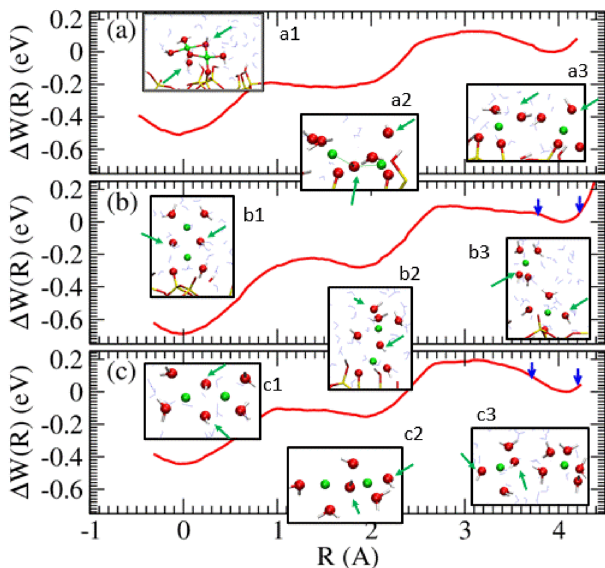
Fig. 3 AIMD/PMF pro fi les along the reaction coordinate R for the systems of Fig. 1a – c. AIMD snapshots along the pro fi le are depicted as insets. Green arrows indicate the OH − positions in the snapshots; note that OH − identity can vary in picosecond time scales. The blue arrows represent integration limits. For further detail see Sec. S4. Δ G dimer = − 0.51, − 0.59, and − 0.38 eV for ( a – c